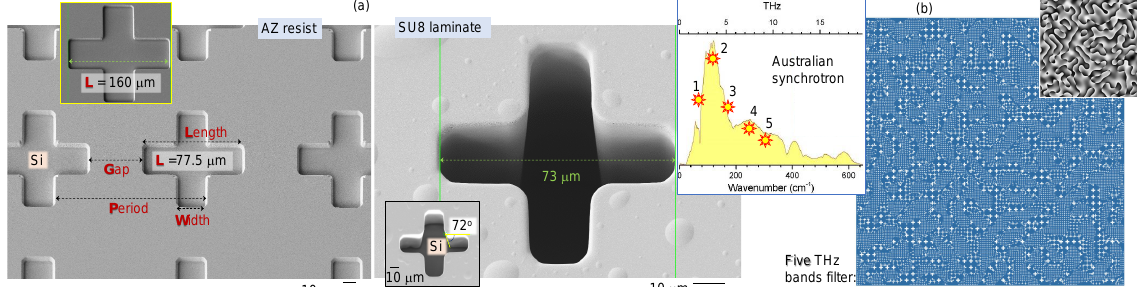
Figure 8. ( a ) SEM images of THz filters defined by photolithography: ∼ 6 µ m-thick AZ4562 resist (applied on surface) and SU8 laminate 20–500 µ m thickness (SUEX from DJ Microlaminates Ltd.; applied or free-standing.) The period, length and width P , L , W define the central wavelength λ 0 and the bandwidth ∆ λ of the filter [38]; gap G = P − L . ( b ) Superimposed five THz bands filter based on the cross apertures ( a ). The binary mask (false colour) and the ( 0 − 2 π ) phase map of the filter (see details in Figure 9). Spectrum of Australian synchrotron radiation at the THz beamline [40] is shown with selected five frequencies